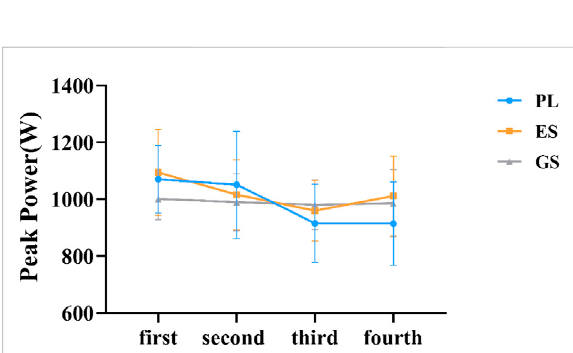
FIGURE 3 Trend of peak power. The horizontal coordinate represents the order of WACT in the experiment. The fi gure represents the mean ± SD of peak power data for three